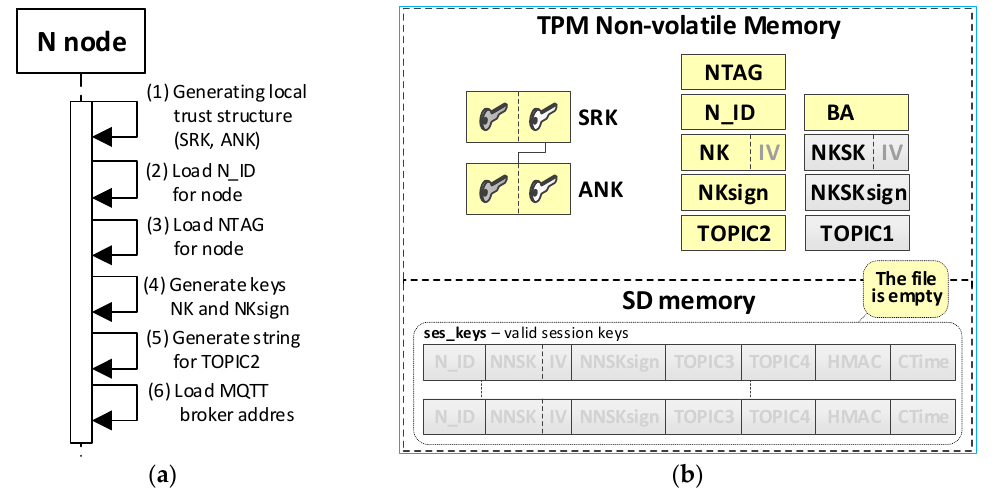
Figure 11. The sequence diagram for the N node initialization procedure ( a ) and the data stored on the KS node after the initialization procedure ( b ).